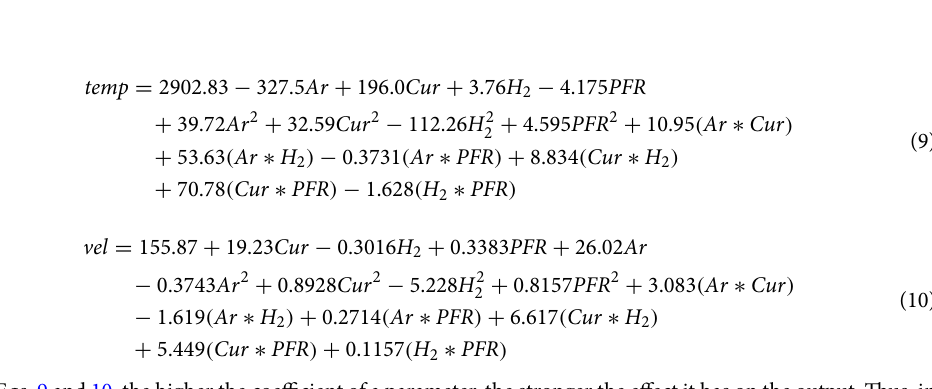
Table 3. Analysis of Variance (ANOVA) for MPCs. The p -value less than 0.05 implies that the variable is